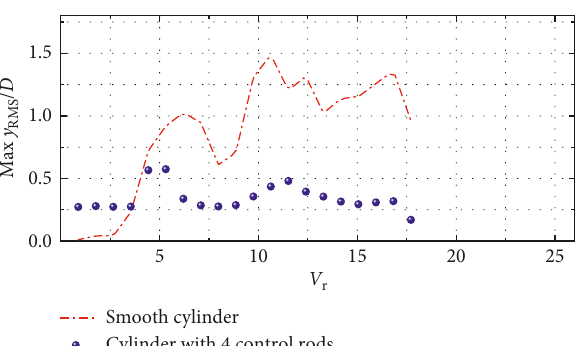
Figure 11: Maximum RMS dimensionless displacement of the main inclined flexible cylinder with control rods versus the reduced velocity.